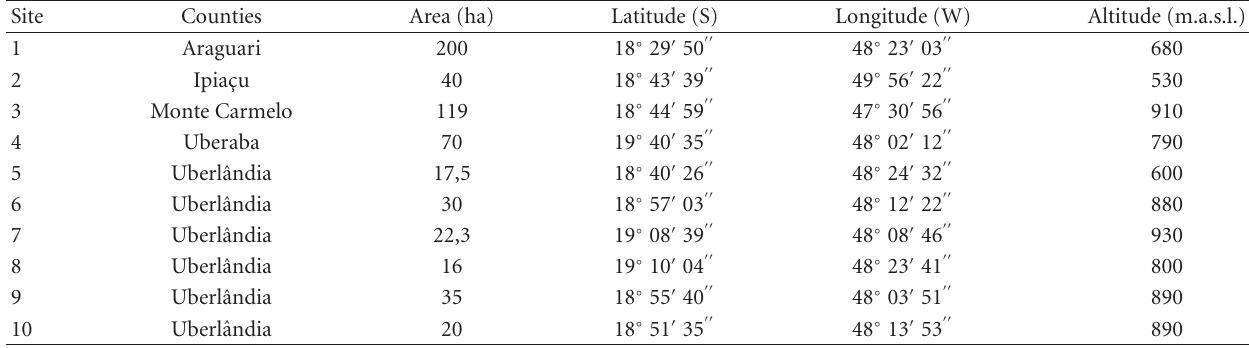
Table 1: Information of ten seasonal semideciduous forest fragments in southeastern Brazil analyzed regarding regional tree flora composition.